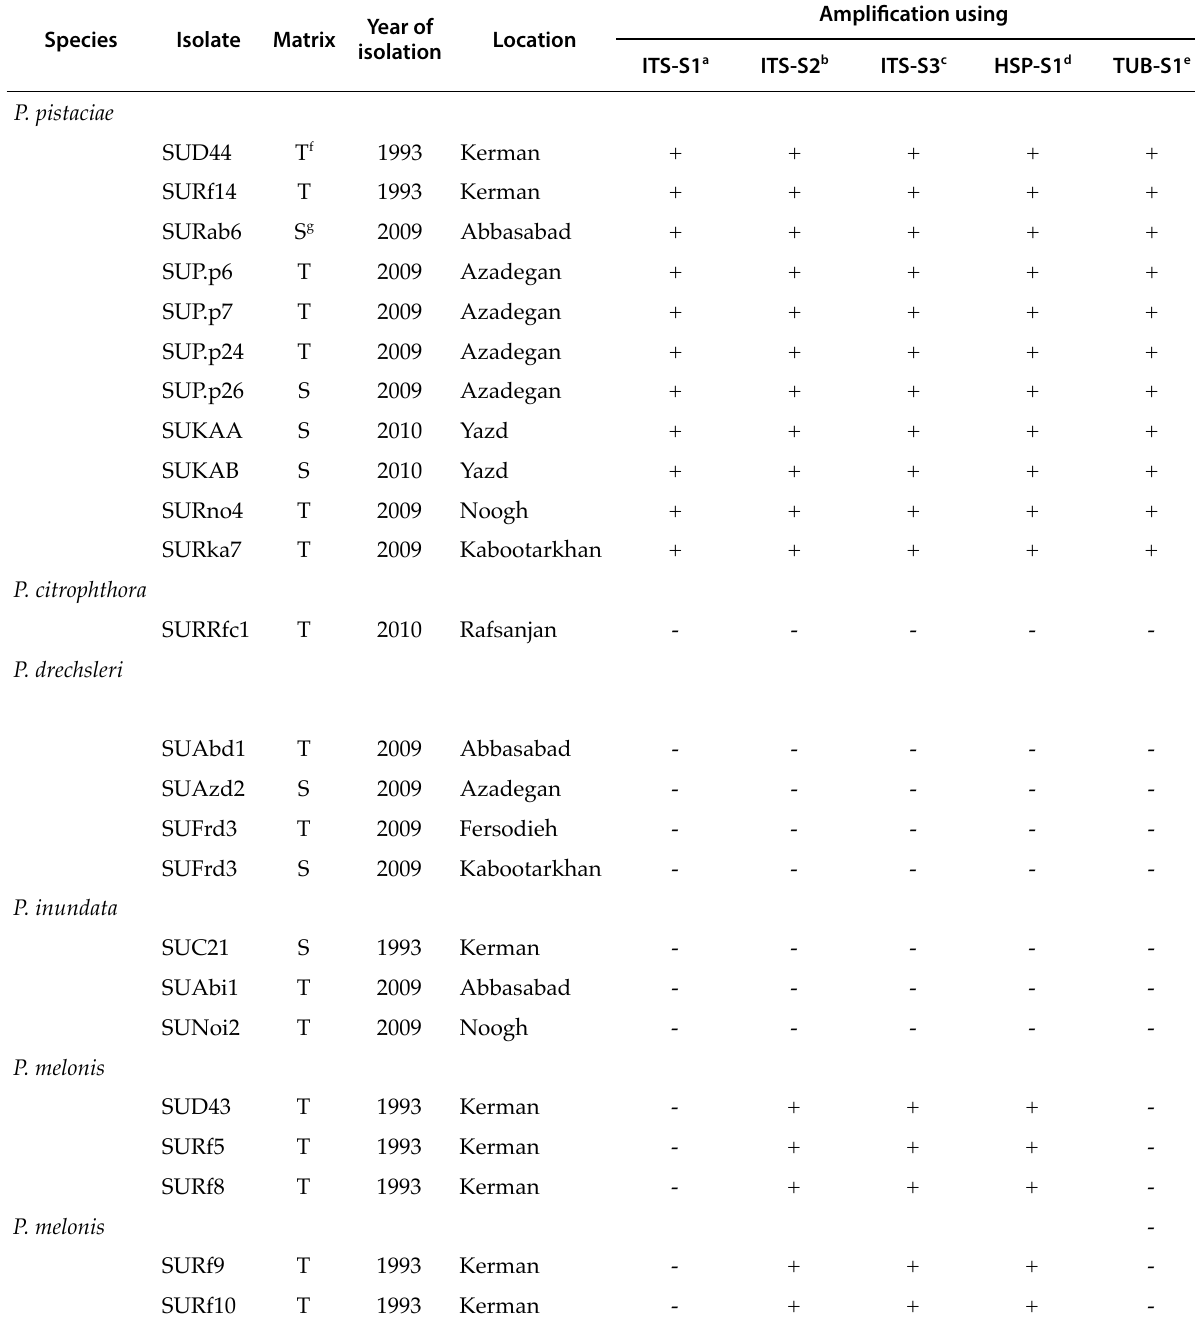
Table 1. Isolates of various Phytophthora spp. recovered either from infected tissues of pistachio trees or from infested soil around the trees in different parts of Iran, and species-specific amplification of their DNA by different primer sets devel - oped in this